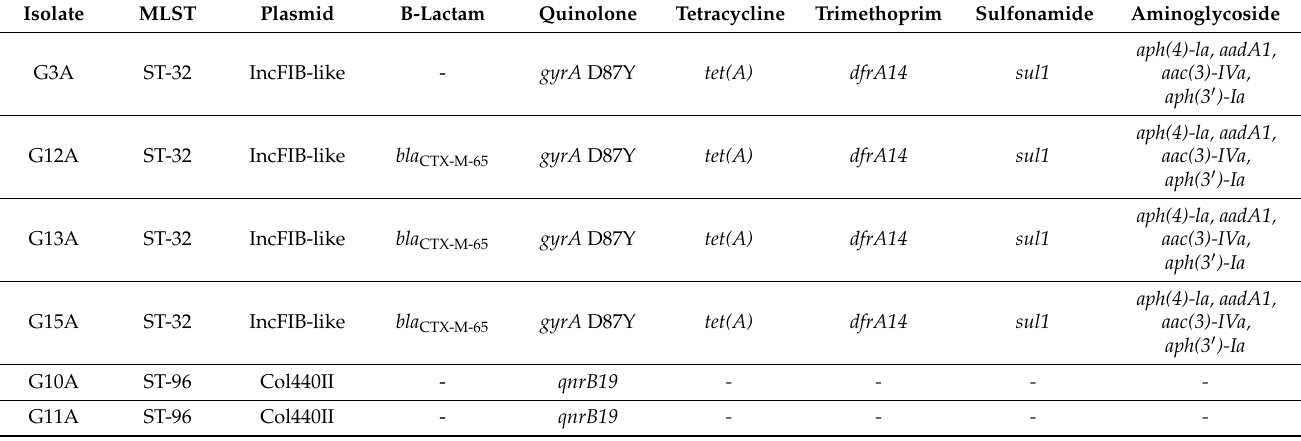
Table 2. Genetic typing and determinants of antimicrobial resistance genes in Salmonella isolates from Galapagos Islands. Isolate MLST